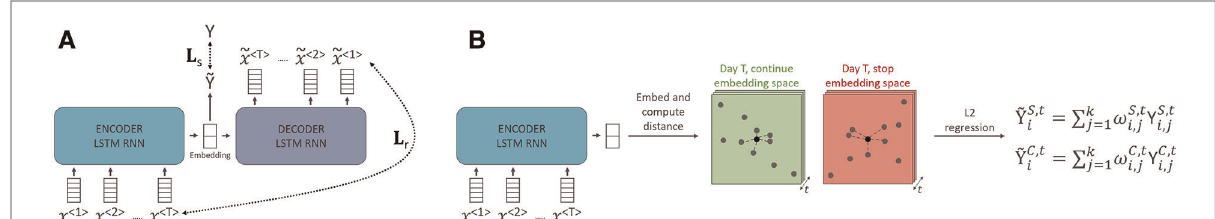
FIGURE 2 Model illustration. ( A ) The encoder is trained using both a supervised loss (Ls) and reconstruction loss (Lr) (3). ( B ) To estimate outcomes during testing, an embedding is created for every day of each patient ’ s stay; embedding spaces are partitioned temporally and based on if the patient stopped or continued antibiotics. The closest k neighbours are selected as donors from each embedding space and L2 regression returns weights that minimise the square difference between the patient and the donors. A stop and continue synthetic control outcome is estimated as a weighted average of the donors ’